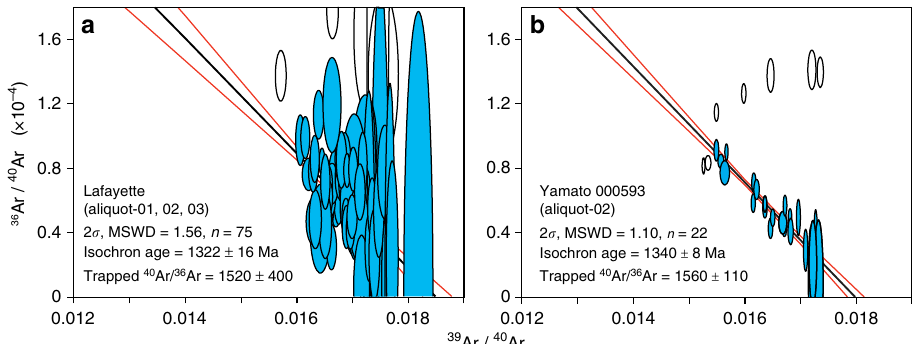
Fig. 4 Trapped Martian 40 Ar/ 36 Ar at the time of nakhlite formation. Isochron analysis of a Lafayette and b Yamato 000593 reveal the composition of initial trapped 40 Ar/ 36 Ar component. All symbols and results are reported at the two-sigma level. Blue ellipses denote plateau steps that were included in the isochron regression, white ellipses are outliers from the low-temperature steps that were excluded from the isochron analysis, and the red lines indicate the 2 σ uncertainty